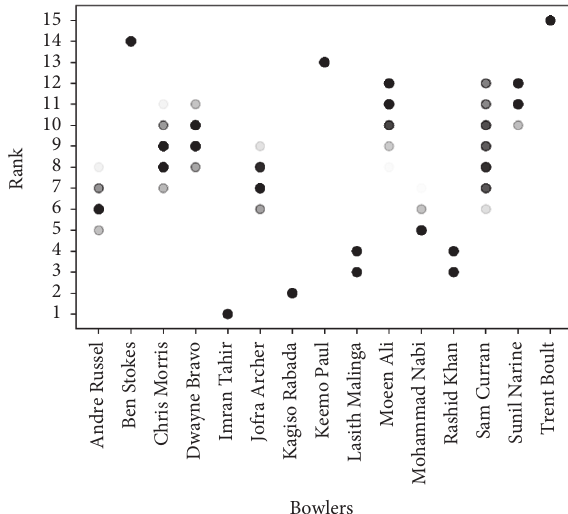
Figure 8: Heat map for bowler ranks by TODIM through shuffled